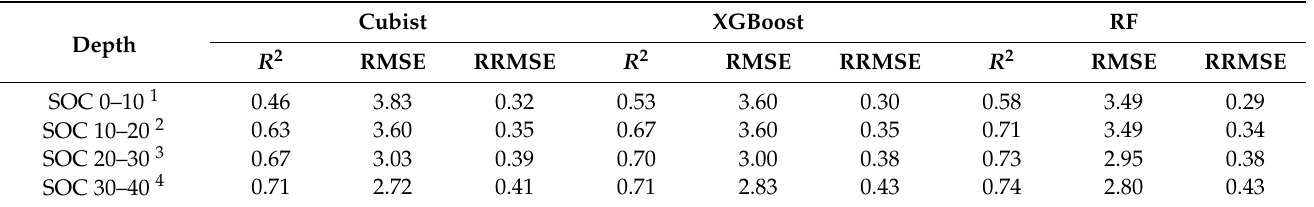
Table 3. Performance of Cubist, XGBoost and RF on the prediction of SOC concentration, assessed by R 2 and RMSE of the independent validation